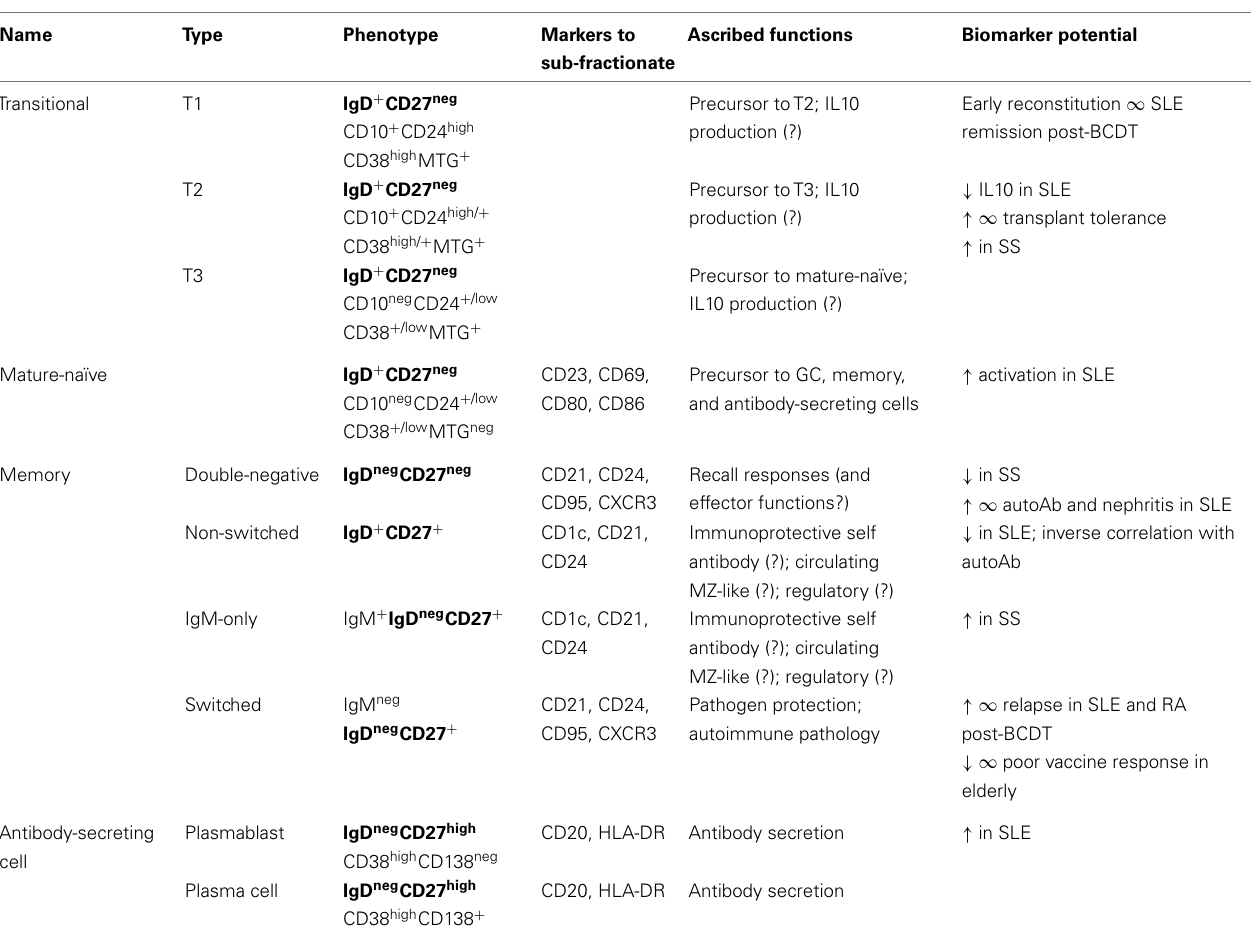
Table 1 | Surface-phenotype defined human peripheral B cell